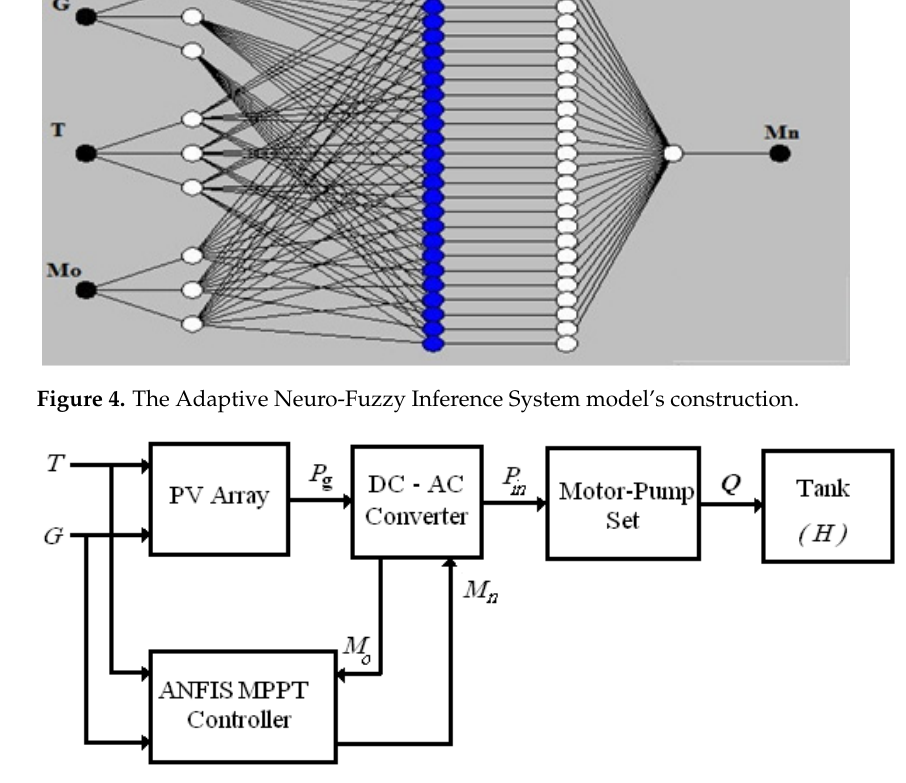
Figure 4. The Adaptive Neuro-Fuzzy Inference System model’s construction.